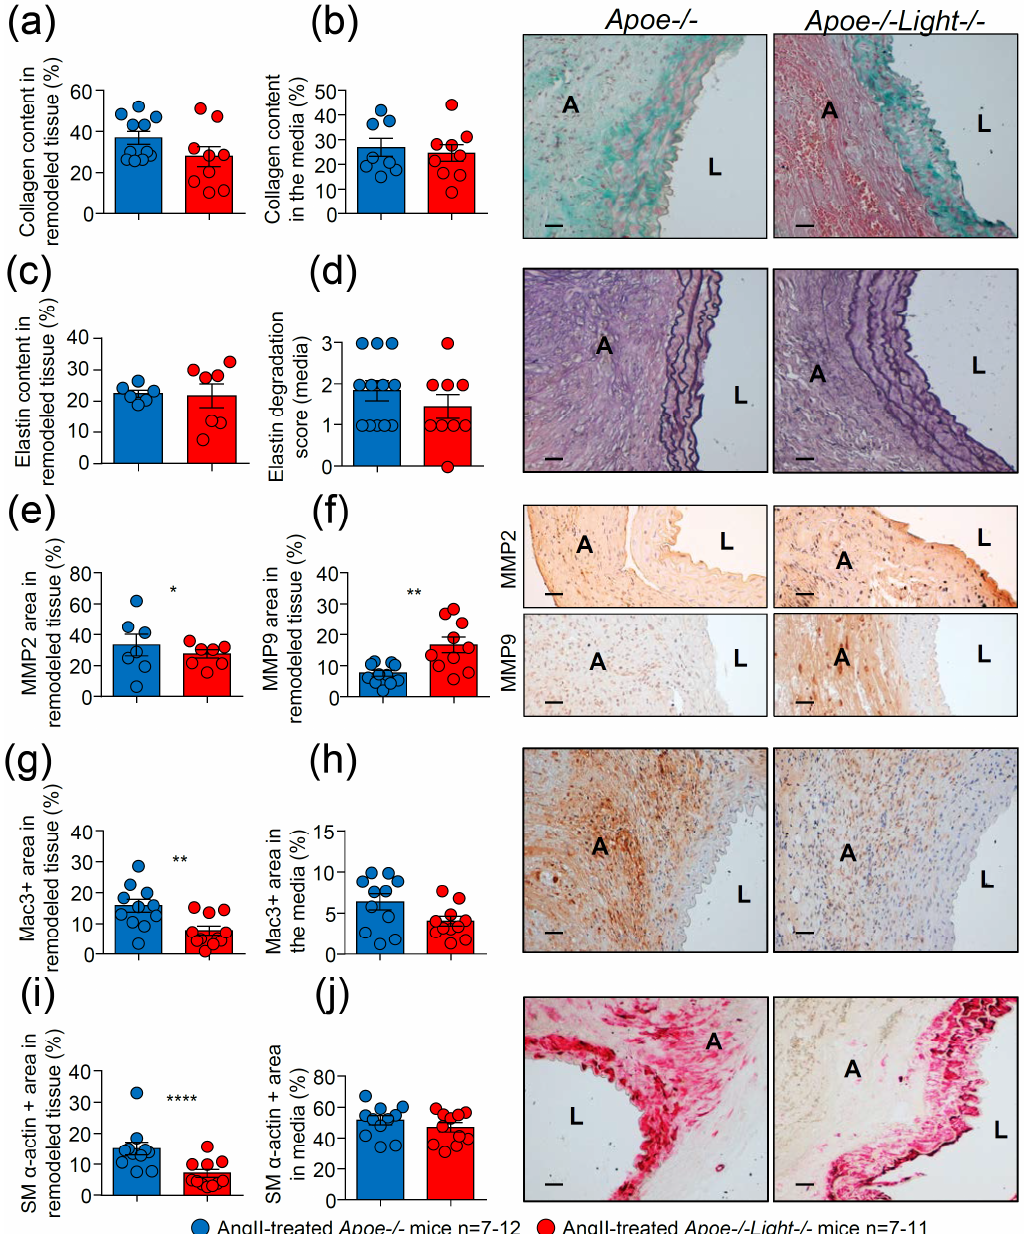
Figure 3. Impact of Light deficiency in AngII–induced dissecting AAA characteristics in Apoe − / − mice. Collagen content in ( a ) the remodeled aneurysm tissue and in ( b ) the media in cross-sections from AngII–treated mice. ( c ) Percentage of elastin in remodeled tissue and ( d ) elastic degradation score in the media in AngII–treated mice. ( e ) MMP2 + , ( f ) MMP9 + , ( g , h ) Mac3 + and ( i , j ) SM α -actin + areas as % in the remodeled aneurysm tissue and in the media in abdominal aortic cross-sections of AngII–treated mice. Representative images of the stainings are shown next to the quantifications. Scale bar: 50 µ m. L: lumen and A: aneurysm. Data are mean ± SEM. Statistical analysis was: Student’s t -test ( a – h , j ) and Mann–Whitney U